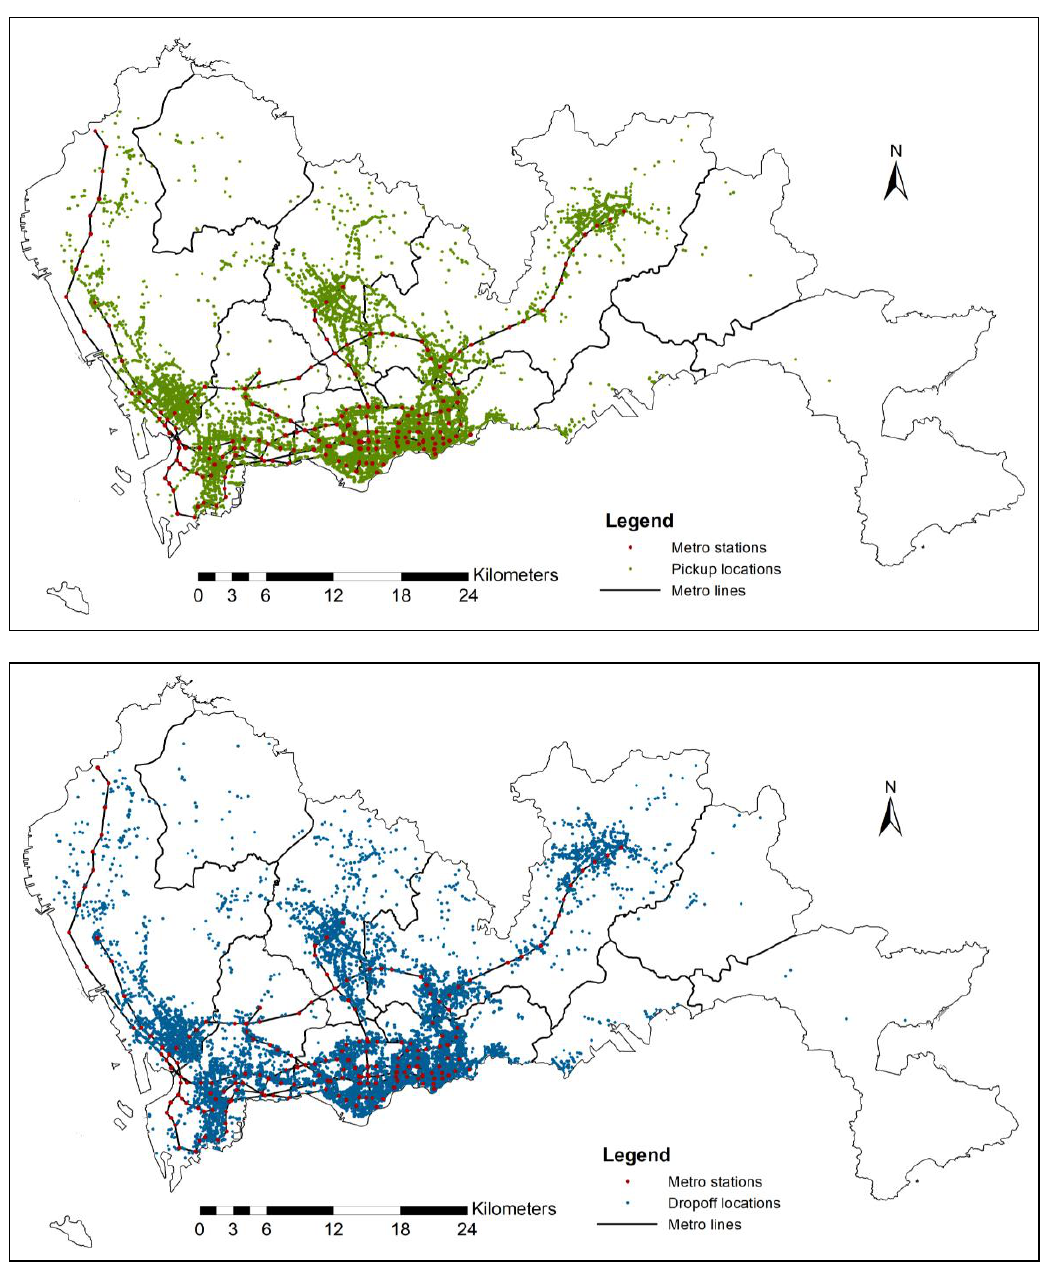
Figure 6. Taxi trip pick-up ( Top ) and taxi drop-off locations ( Bottom ).